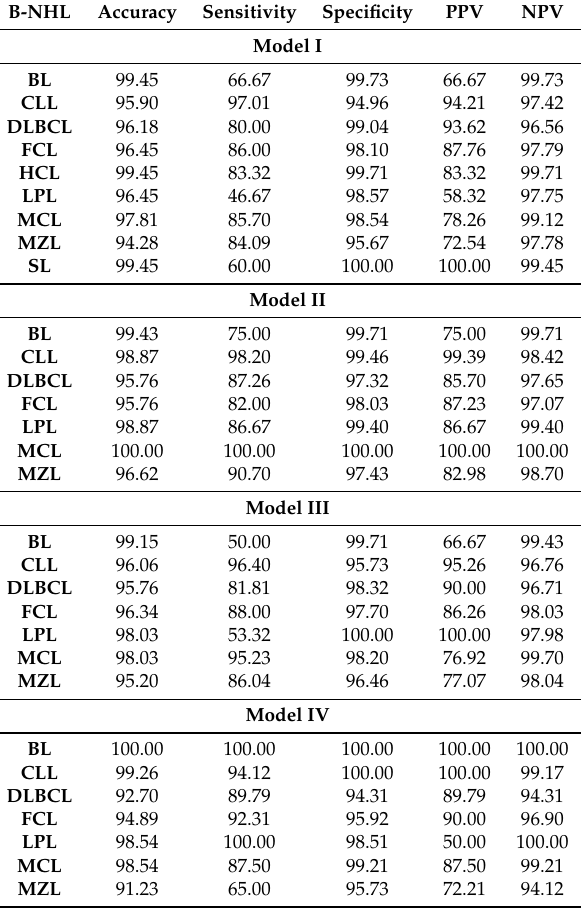
Table 1. Accuracy, sensitivity, specificity, positive predictive value (PPV), and negative predictive value (NPV) for each B-NHL subclass for Model I to IV. All values are